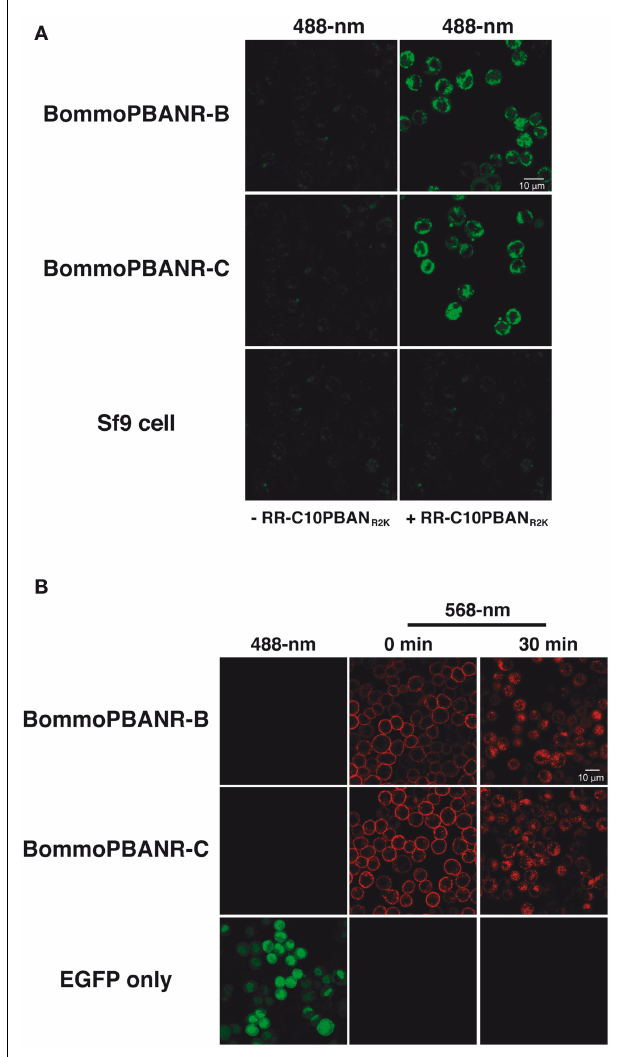
FIGURE 4 | Confocal imaging of Sf9 cell lines stably transformed with non-chimeric BommoPBANR-B and BommoPBANR-C. (A) Dynamics of non-chimeric PBANR variants stably expressed in Sf9 cells upon RR-C10PBAN R2K . (B) Influx of extracellular Ca 2 + upon RR-C10PBAN R2K binding to the intact PBANR variants stably expressed in Sf9 cells.